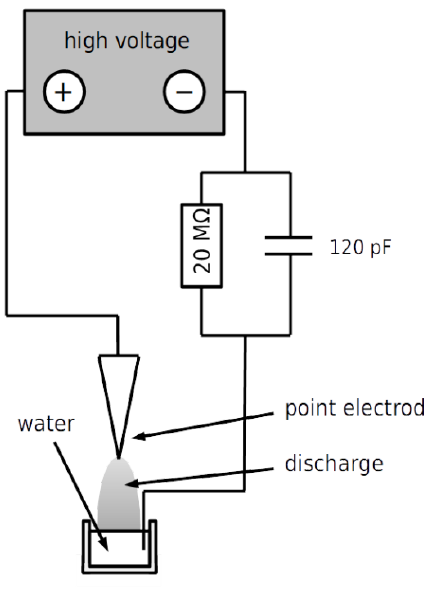
Figure 3. Schematic drawing of the PAW-generating apparatus.